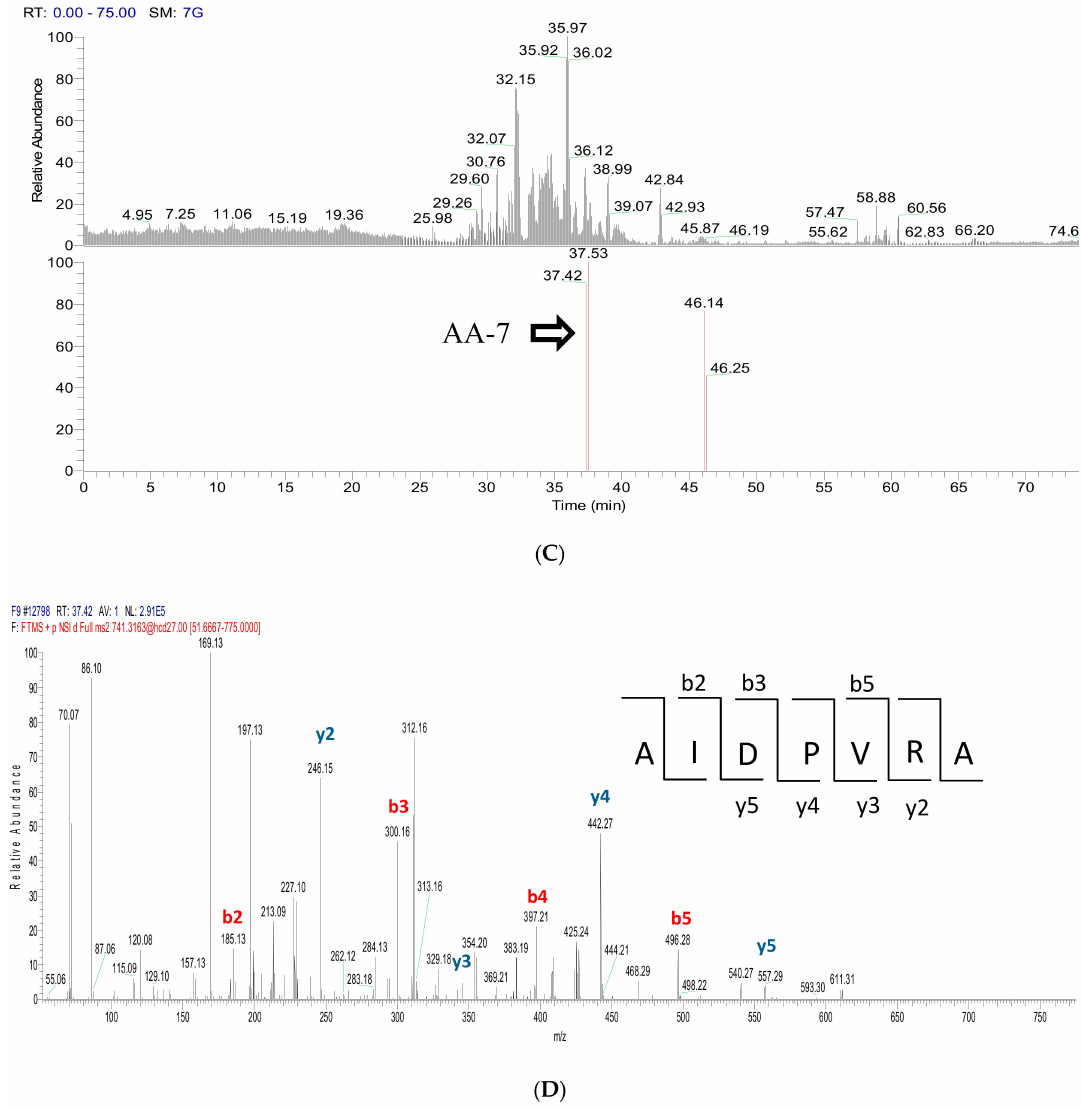
Figure 3. Identification of two peptides from RP-HPLC fraction 9. ( A ) Liquid chromatography-mass spectrometry (LC-MS) chromatogram of RP-HPLC fraction 9 (top). Selective ion chromatogram of m / z 548.2700 (FP-5, peak at t R = 35.96 min) (down); ( B ) Tandem mass spectrometry (MS/MS) spectrum of FP-5 ( m / z 548.2700); ( C ) LC-MS chromatogram of RP-HPLC fraction 9 (top). Selective ion chromatogram of m / z 741.3163 (AA-7, peak at t R = 37.53 min) (down); ( D ) MS/MS spectrum of AA-7 ( m / z